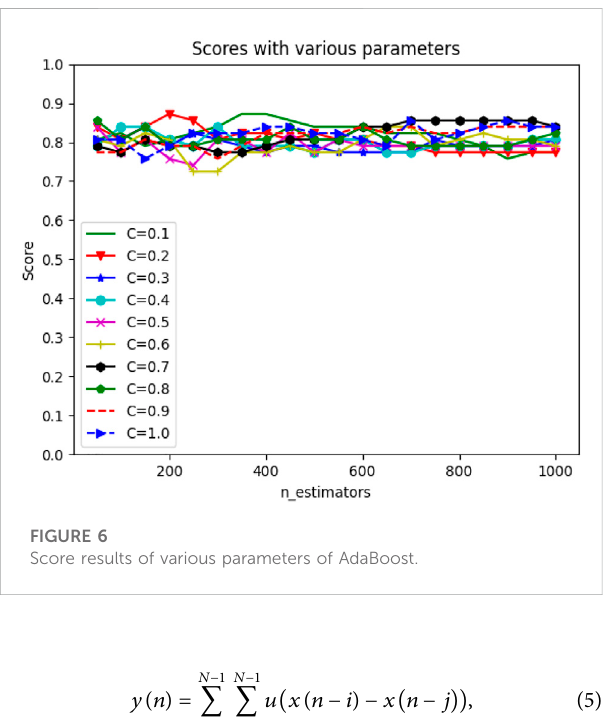
FIGURE 6 Score results of various parameters of AdaBoost.